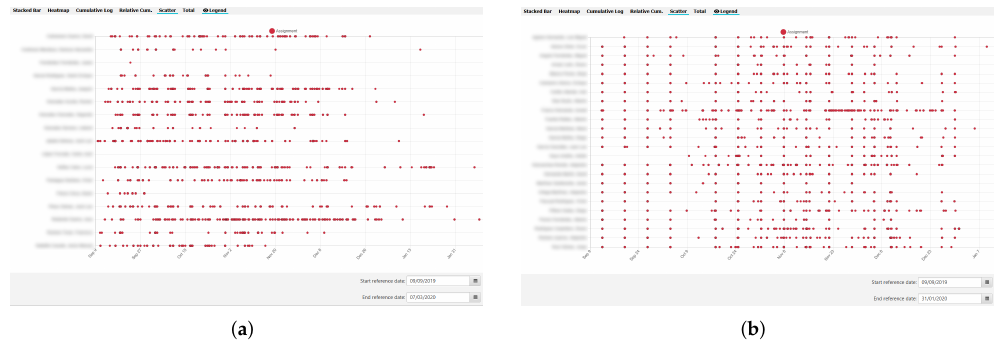
Figure 16. Scatter chart with assignments. ( a ) Online learning. ( b ) Blended